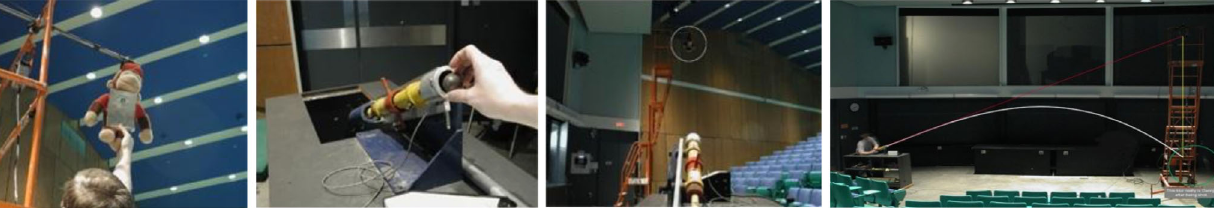
FIG. 3. Shoot the Monkey setup images.